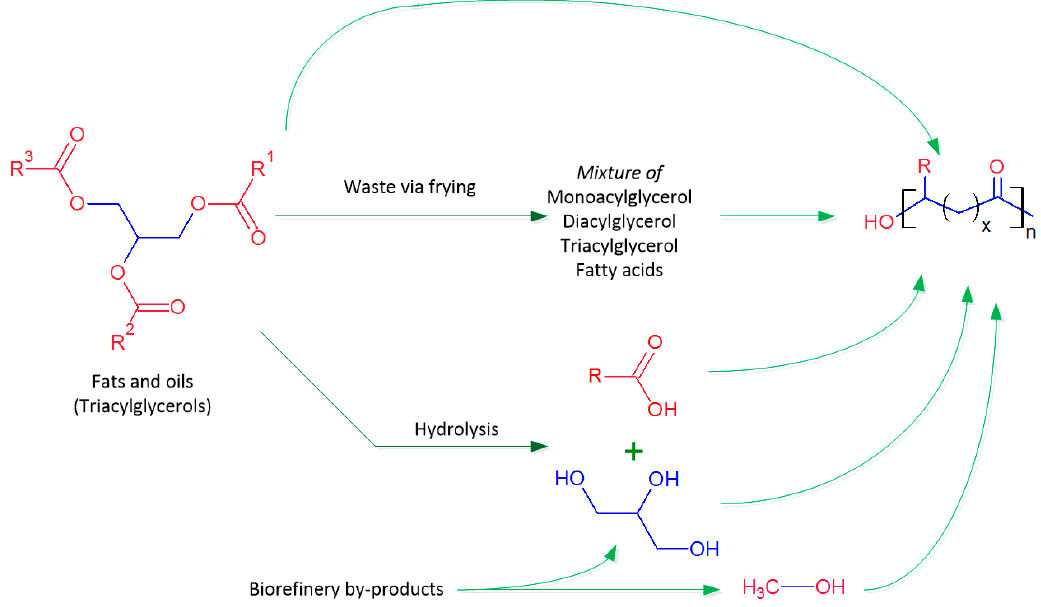
Figure 4. Fats and oils as substrates for PHA production via fermentation of various